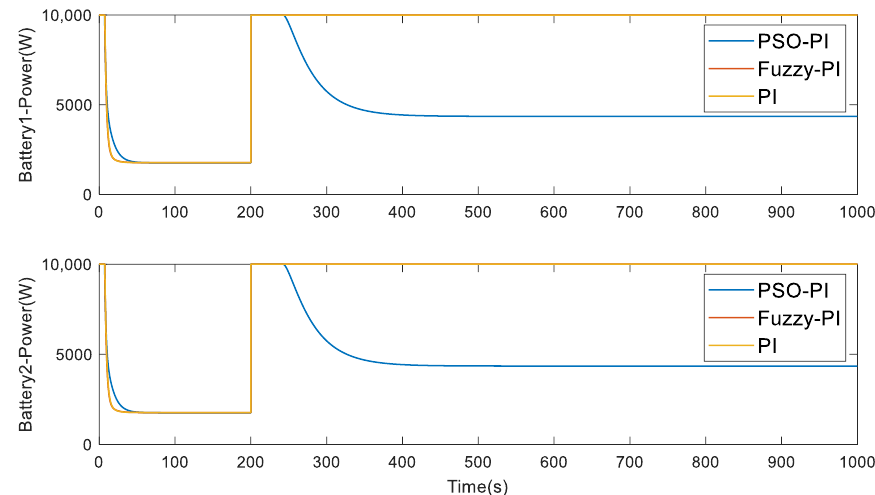
Figure 37. Output power of storage battery when one generator fails. The output power of AA-CAES is shown in Figure 38.